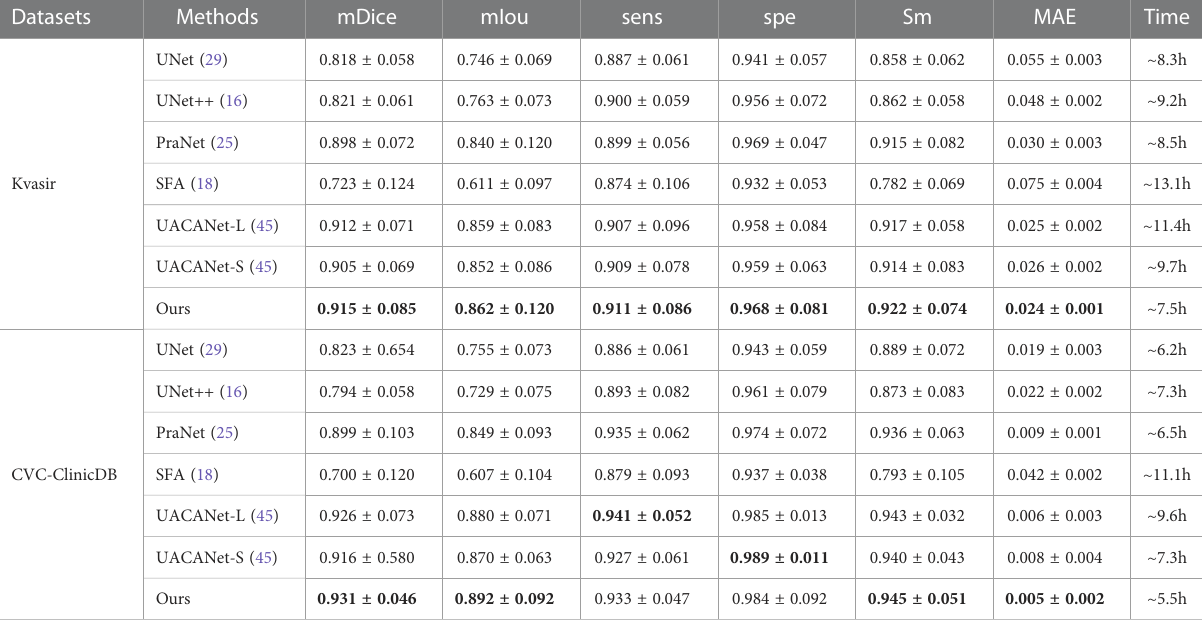
TABLE 2 Comparison of segmentation effects of different methods on Kvasir and CVC-ClinicDB datasets.